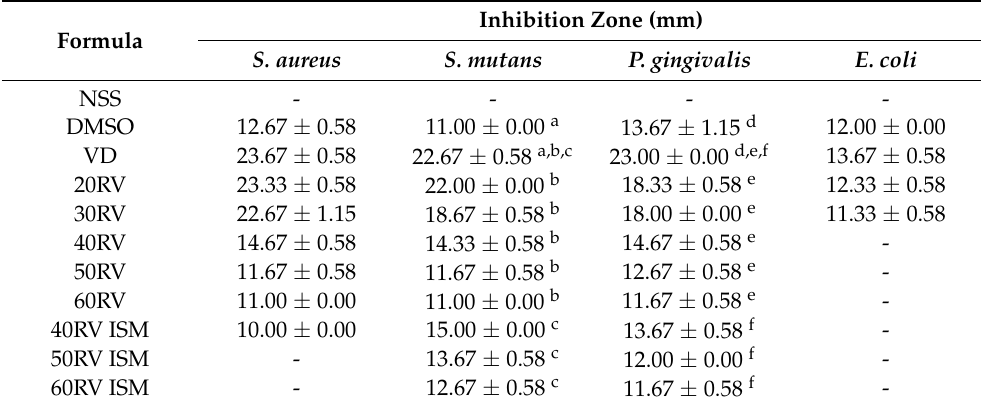
Table 5. Inhibition zone diameters of NSS, DMSO, vancomycin HCl-loaded rosin-based ISG and ISM formulations against S. aureus , S. mutans , P. gingivalis , and E. coli ( n =